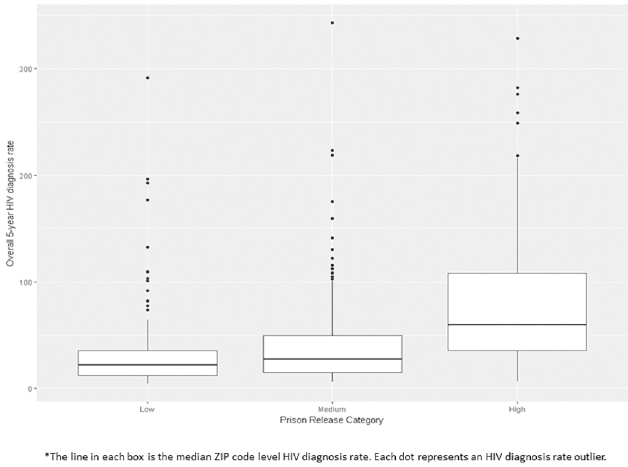
Fig 2. Boxplots of 5-year HIV diagnoses rates by prison release category (low, medium, high) (cid:3) .